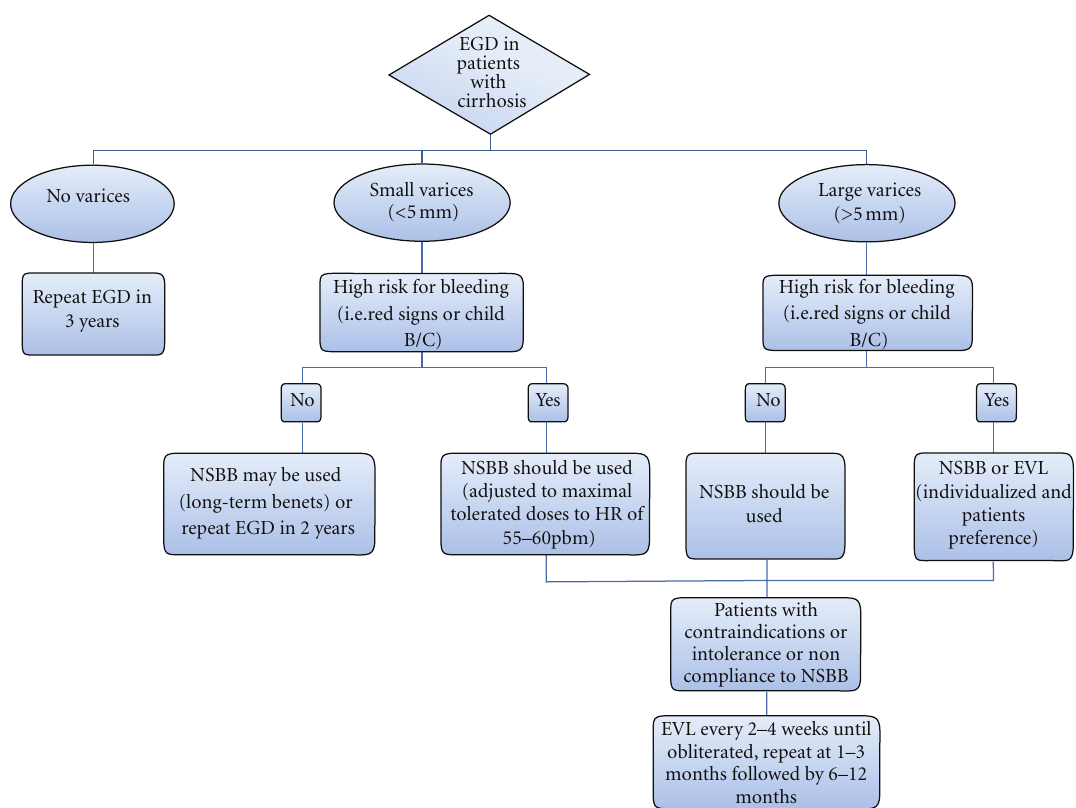
Figure 2: Algorithm for screening for esophageal varices and primary prophylaxis of variceal bleeding in cirrhotic patients. EGD indicates esophagogastroduodenal endoscopy; NSBB: nonselective beta blockers; EVL: endoscopic variceal ligation; HR: heart